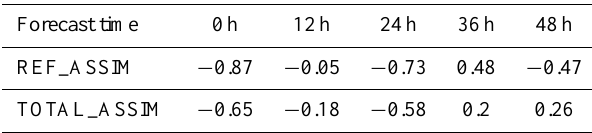
Table 3. Levels of 2m temperature, bias of REF_ASSIM and TO- TAL_ASSIM for forecast times 0, 12, 24, 36 and 48h, average for the period of 10 to 25 April 2012 over the same selection of weather stations as Table